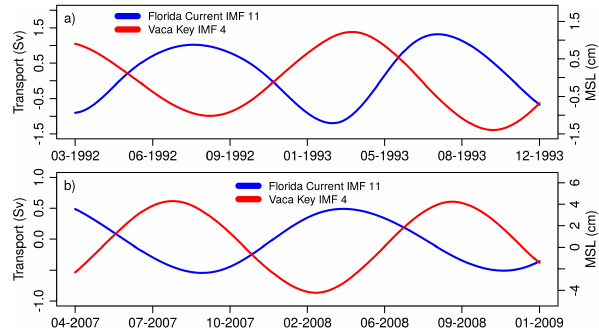
Figure 6. Florida Current transport ( N IMF = 17) and Vaca Key MSL ( N IMF = 9) IMFs with Hilbert spectrum